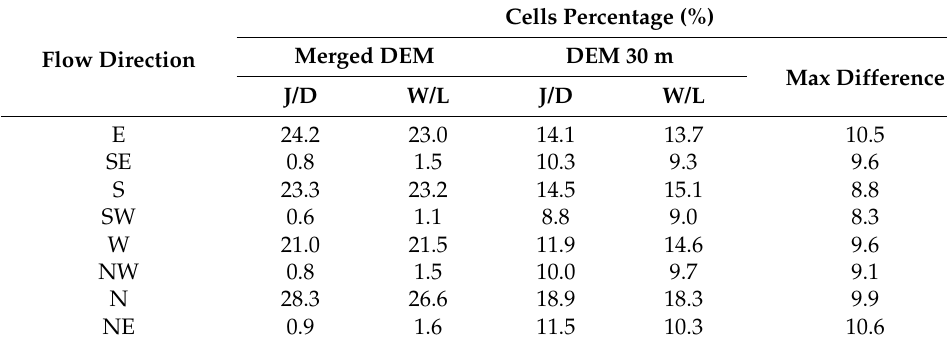
Table 5. Cell percentage according to flow directions.